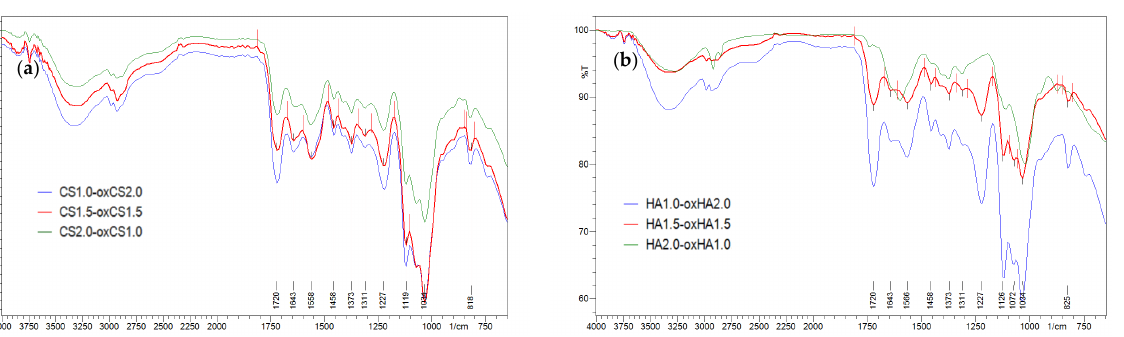
Figure 7. FT-IR spectra of API-CS-oxCS/oxHA hydrogels: ( a ) FA-CS-oxCS vs. CS-oxCS and FA; ( b ) FA-CS-oxHA vs. CS-oxHA and FA; ( c ) Ala-CS-oxCS vs. CS-oxCS and Ala; ( d ) Ala-CS-oxHA vs. CS-oxHA and Ala; ( e ) CoQ10-CS-oxCS vs. CS-oxCS and CoQ10: ( f ) CoQ10-CS-oxHA vs. CS-oxHA and CoQ10.